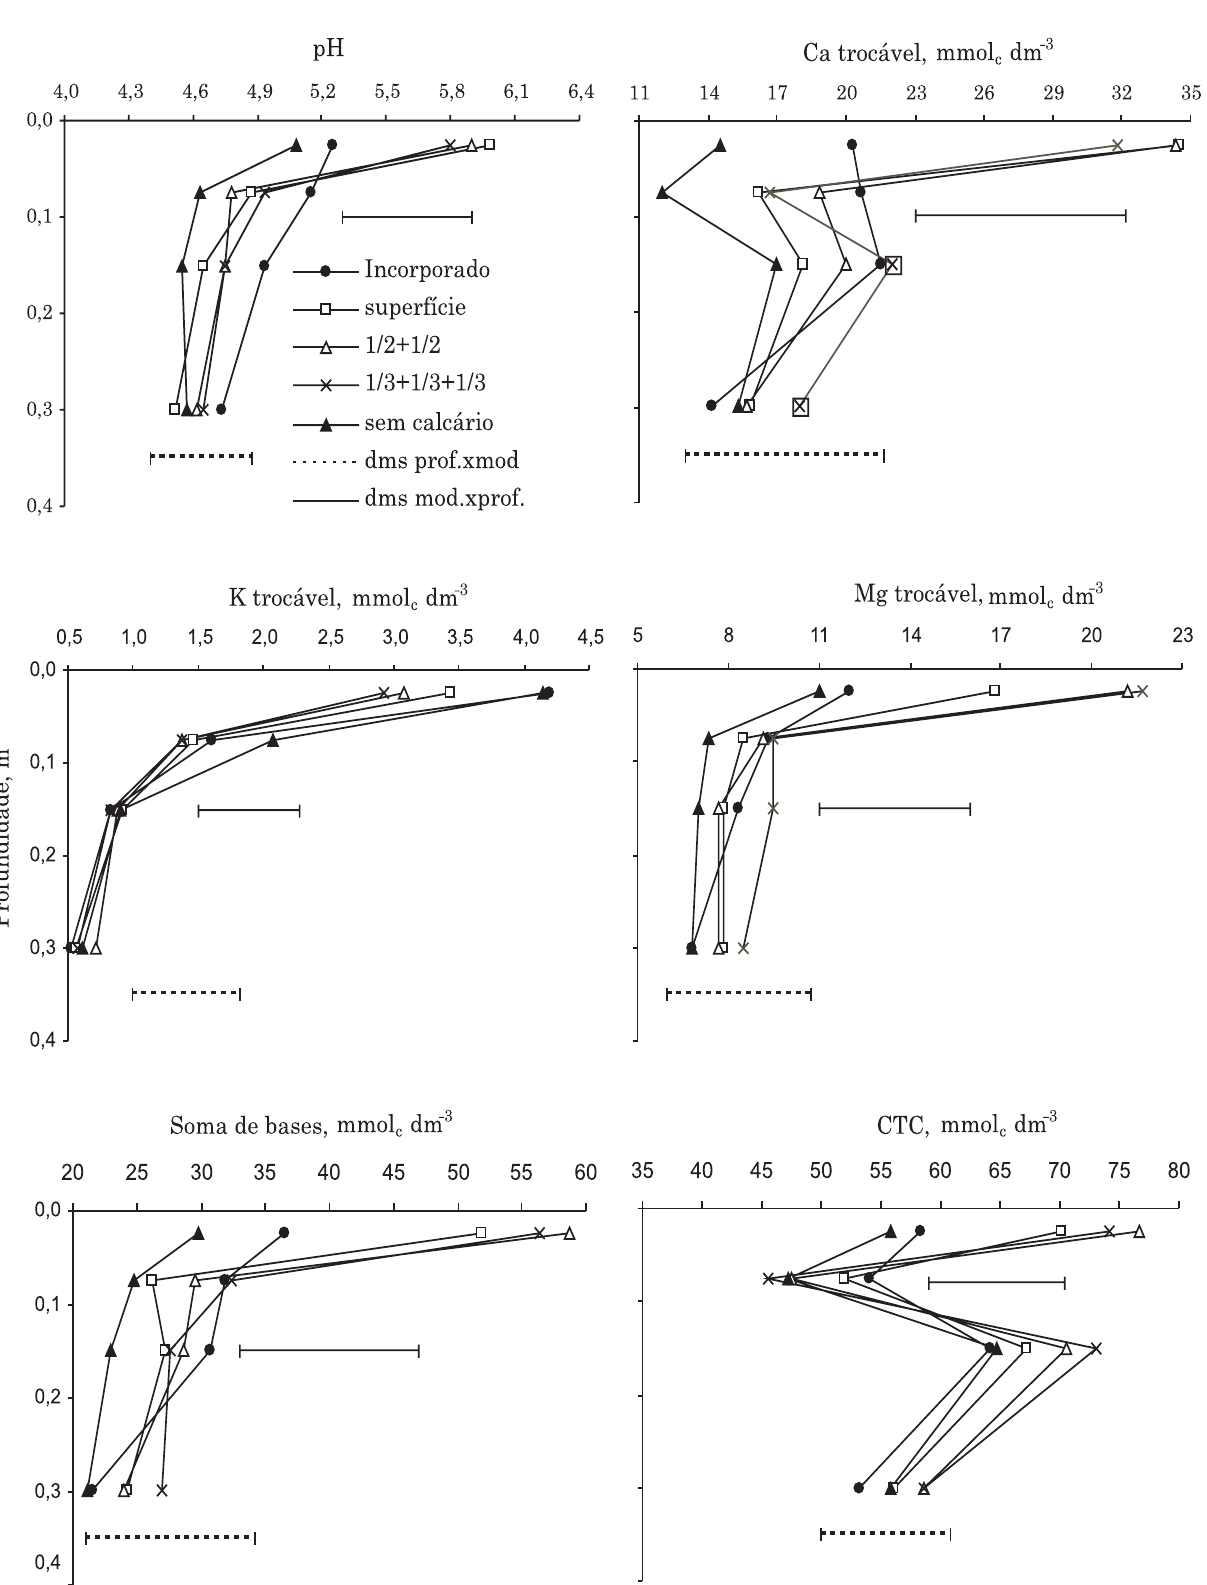
Figura 2. Médias de pH, teores de bases (Ca 2+ , Mg 2+ e K 2+ ), soma de bases e CTC a pH 7,0 considerando a profundidade de amostragem e modos de aplicação de calcário. (dms = diferença mínima significativa, Tukey a 5